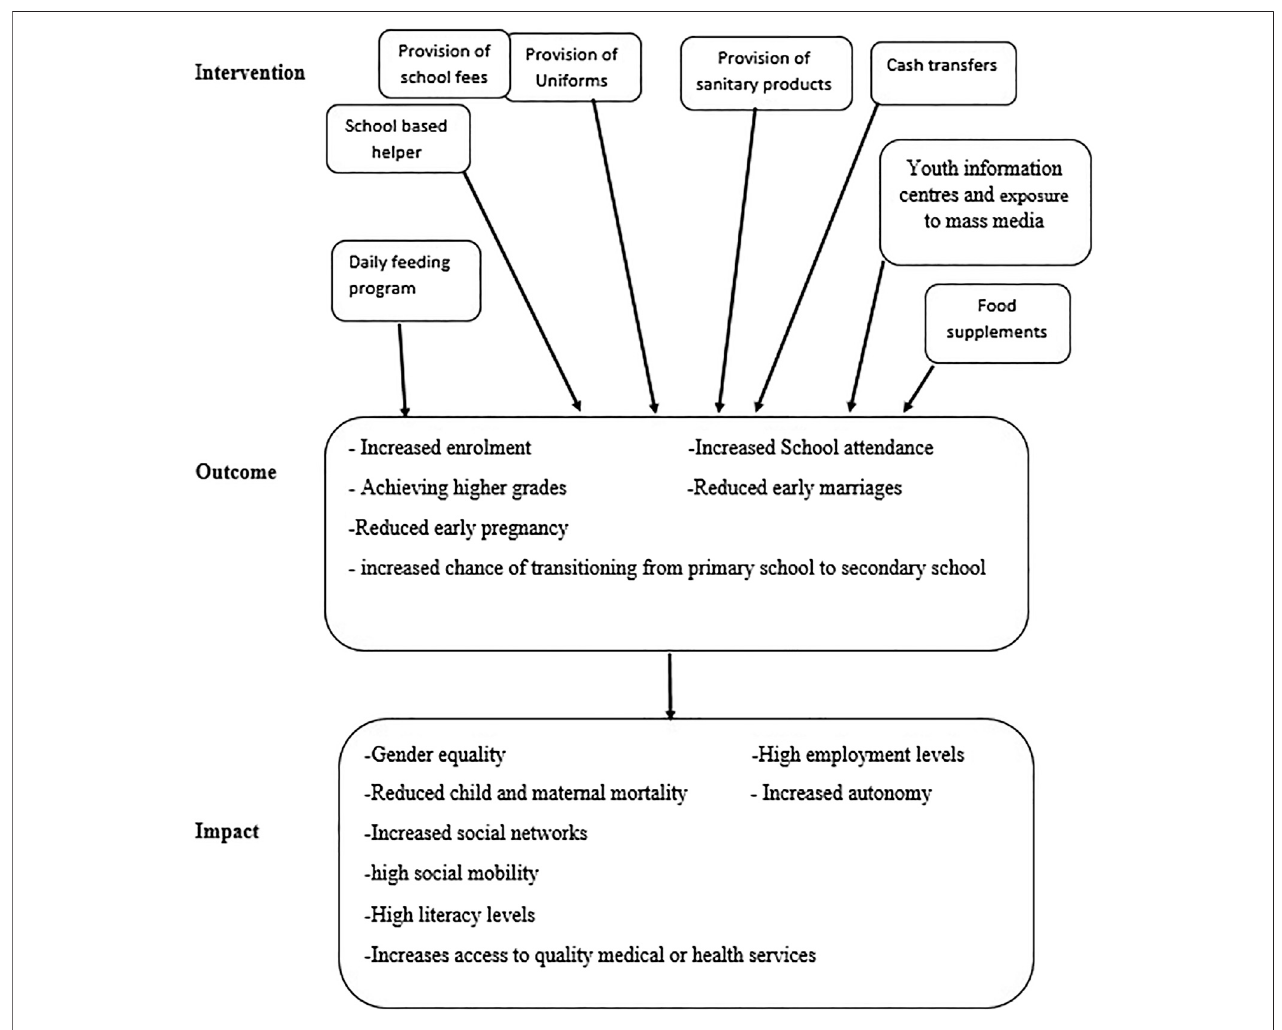
FIGURE 3 | Updated iterative logic